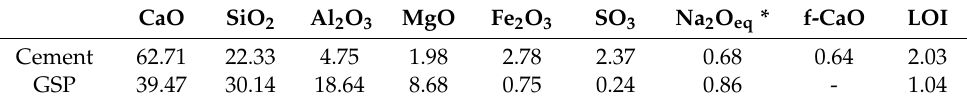
Table 1. Chemical compositions of the cement and ground slag powder (GSP)/%.